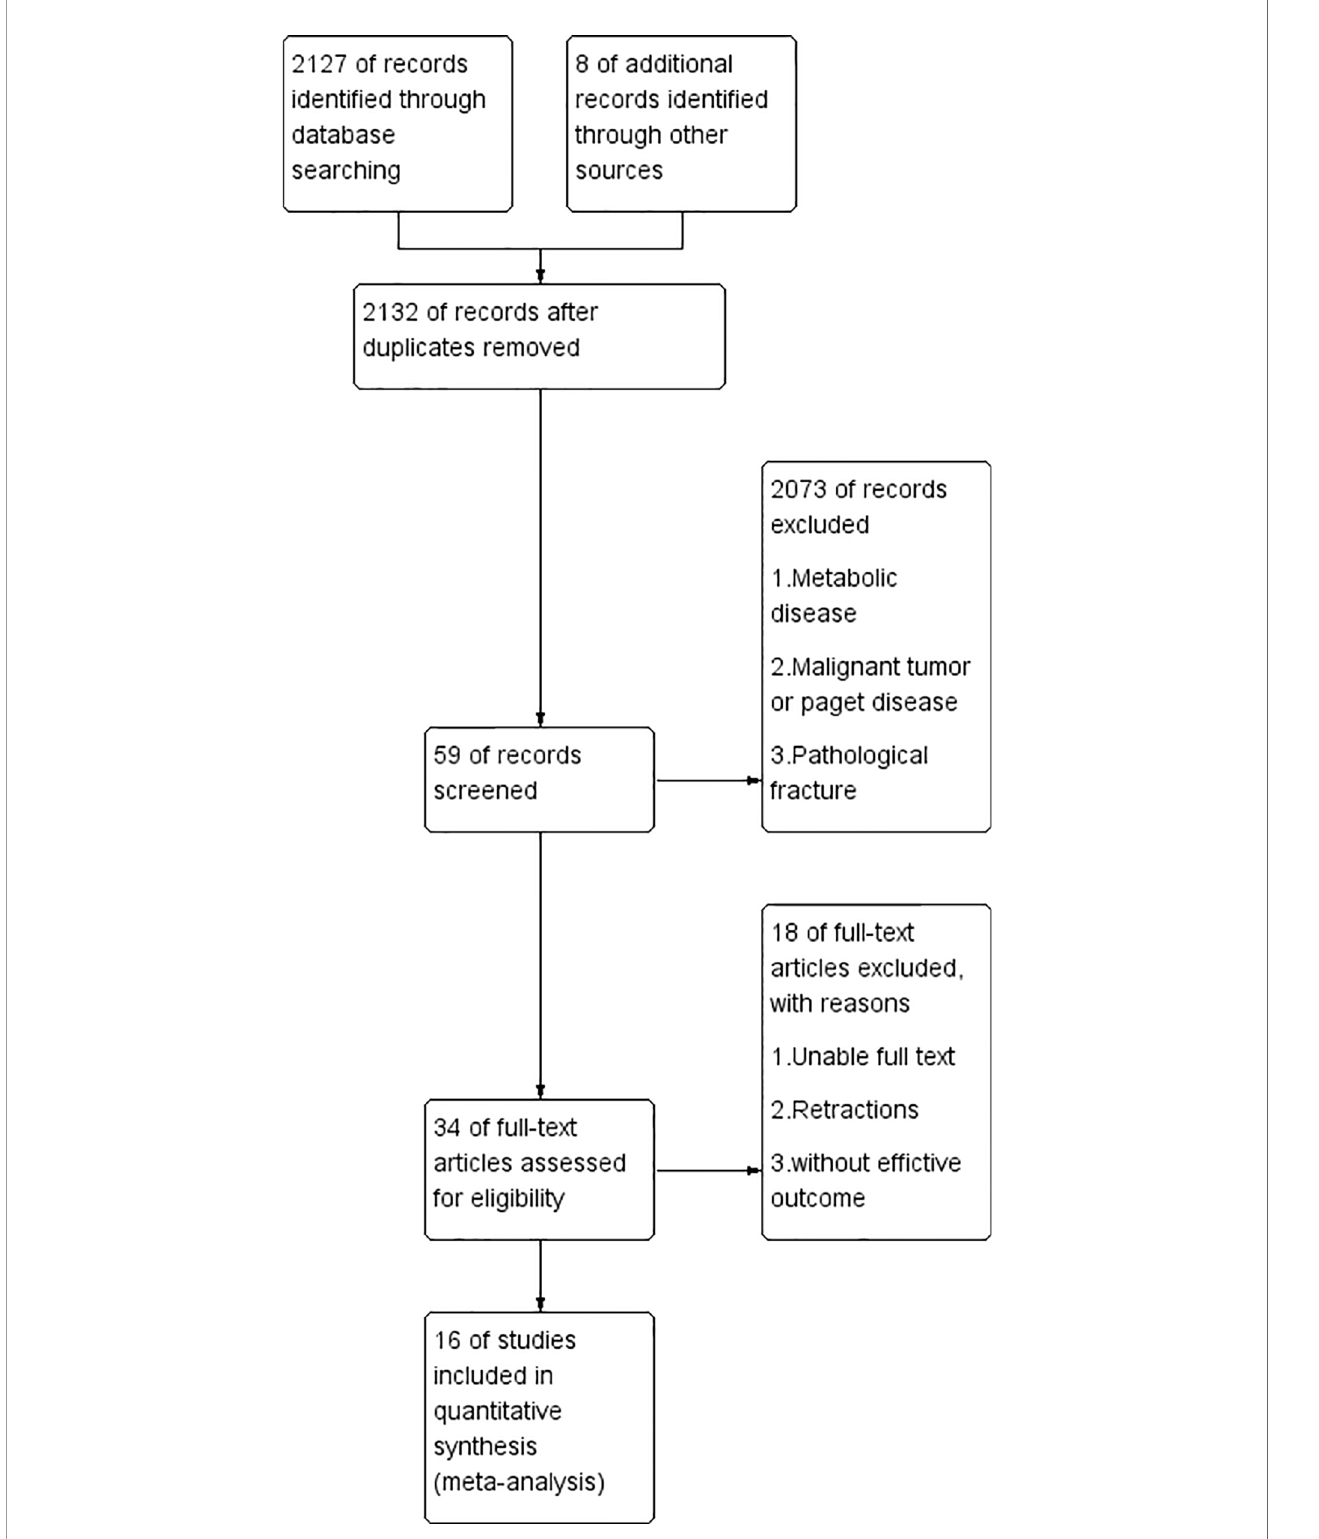
FIGURE 1 | Flow diagram for the review